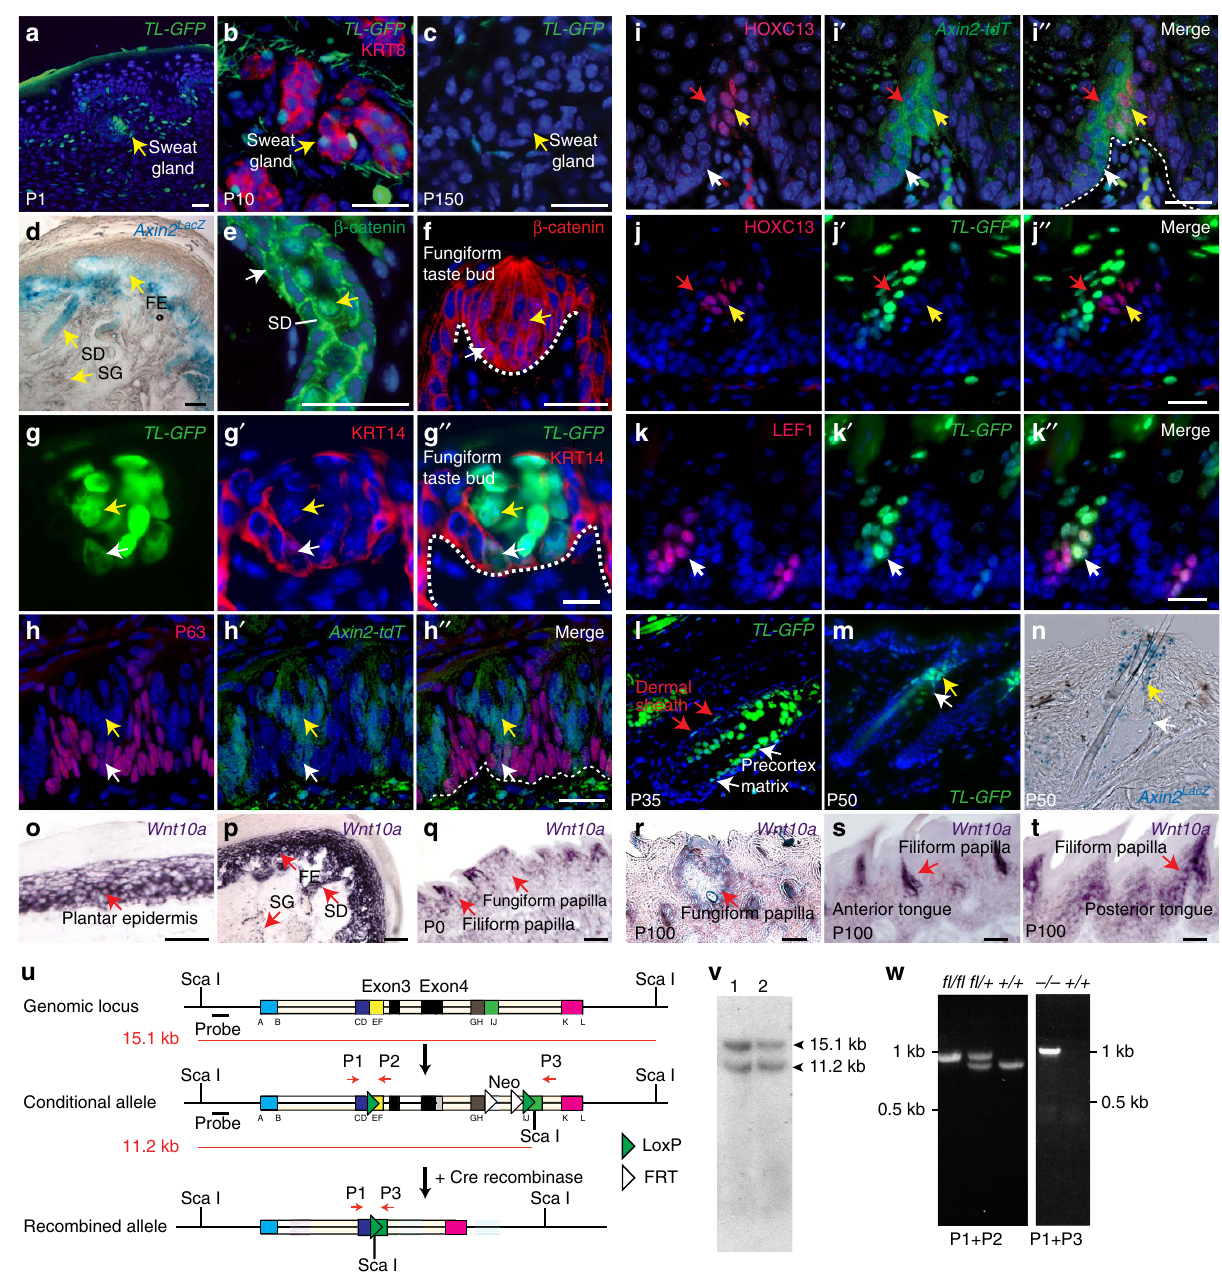
Figure 2 | Wnt/ b -catenin signalling and generation of Wnt10a mutant mice. ( a – c ) TL-GFP localizes to sweat gland (SG) germs at P1 ( a ), and KRT8 þ SG luminal cells at P10 ( b ), but not adult SG secretory cells ( c ). ( d ) Axin2 lacZ localizes to sweat ducts (SD) and footpad epidermis (FE), but not SG secretory cells in adult footpad. ( e ) Nuclear and cytoplasmic b -catenin localizes to basal (white arrow) and suprabasal (yellow arrow) cells in adult sweat ducts. ( f ) Nuclear b -catenin localizes to basal (white arrow) and differentiated (yellow arrow) adult fungiform TB cells. ( g – g 00 ) TL-GFP localizes to KRT14 þ basal (white arrows) and KRT14 (cid:2) differentiated (yellow arrows) TB cells. ( h – h 00 ) tdTexpression (pink) in p63 þ basal (white arrows) and p63 (cid:2) differentiating (yellow arrows) cells in Axin2-Cre ERT2/tdT ( Axin2-tdT ) circumvallate papillae. ( i – i 00 ) tdT expression in posterior HOXC13 þ (yellow arrows), anterior HOXC13 (cid:2) differentiating (red arrows) and HOXC13 (cid:2) basal (white arrows) filiform papilla cells in Axin2-tdT mice. ( j – k 00 ) TL-GFP localizes to anterior HOXC13 (cid:2) differentiating ( j – j 00 , red arrows) and LEF1 þ basal ( k – k 00 , white arrows) but not posterior HOXC13 þ differentiating ( j – j 00 , yellow arrows) filiform papilla cells. ( l ) TL-GFP localizes to matrix, pre-cortex and dermal sheath in P35 anagen HFs. ( m , n ) TL-GFP ( m ) and Axin2 lacZ ( n ) localize to HF isthmus (yellow arrows) and sebaceous gland peripheral cells (white arrows) at P50 (telogen). ( o – t ) Wnt10a expression ( in situ hybridization, purple) in adult plantar epidermis ( o ); adult footpad epidermis (FE) and sweat ducts (SD) ( p ); neonatal ( q ) and P100 ( r – t ) filiform and fungiform papillae in anterior ( s ) and posterior ( t ) dorsal tongue; and myoepithelial cells of adult SG (lower red arrow) ( p ). ( u – w ) Generation of Wnt10a -floxed mice. ( u ) A conditional Wnt10a allele was generated by recombination using a cassette with loxP sites flanking exons 3–4. Correctly targeted ES cells were confirmed by Southern blotting of Sca1-digested genomic DNA ( v ); probe is indicated in u . ( w ) PCR-genotyping with primers P1 þ P2 confirmed germ-line transmission. Wnt10a fl/fl mice were crossed with CMV-Cre mice to generate a null allele. PCR-genotyping with primers P1 þ P3 confirmed deletion of exons 3–4, encoding amino acids 126–528. Primer positions are indicated in u . Scale bar, 10 m m ( g – g 00 ) or 25 m m (other